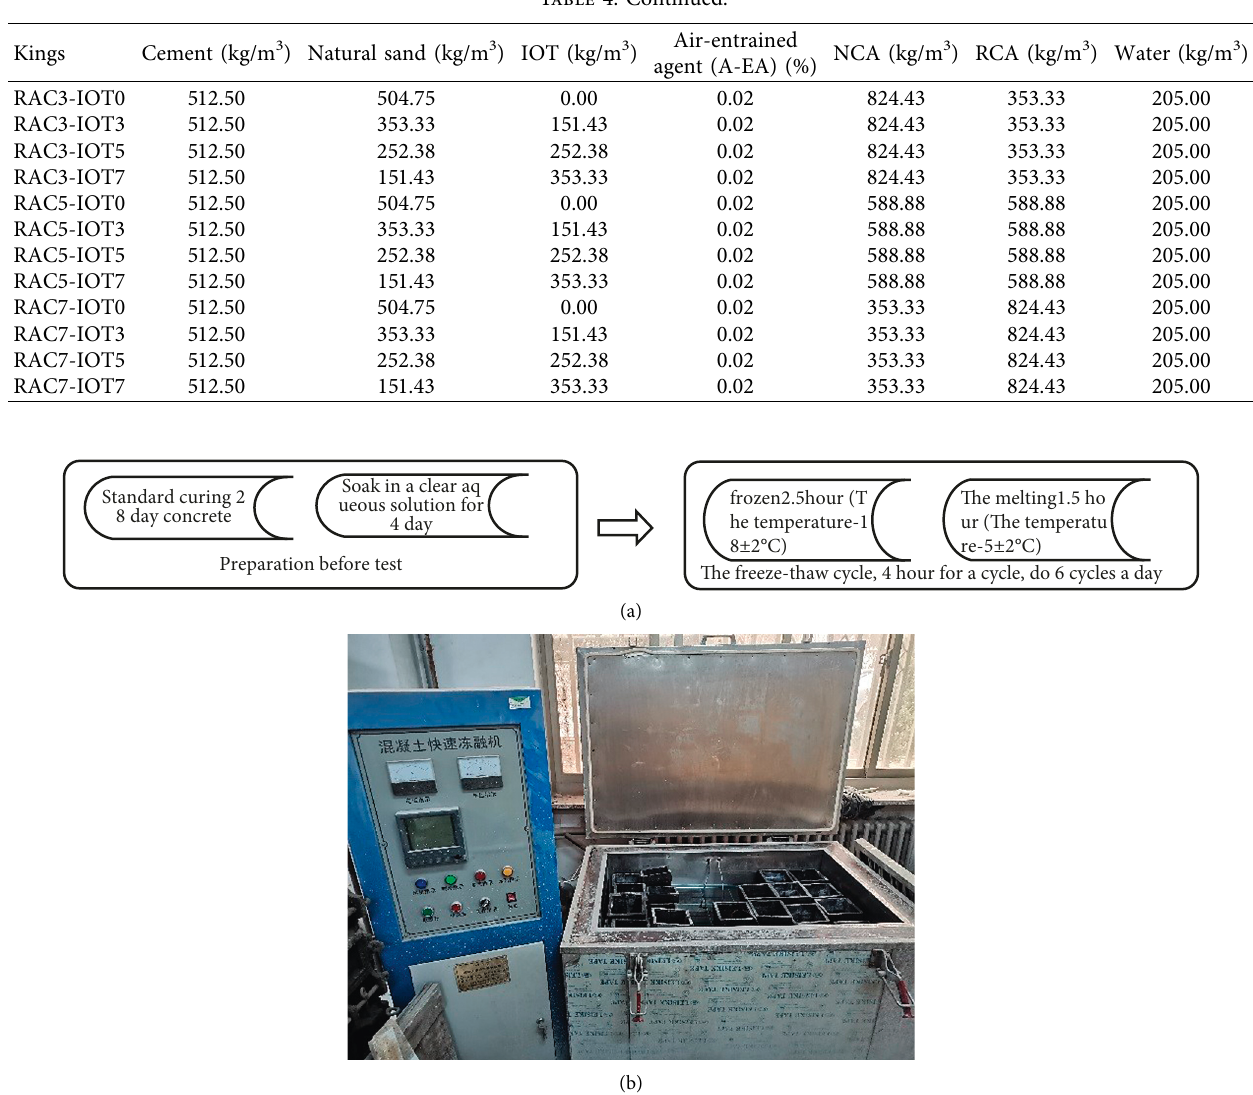
Figure 4: F-T cycle flow chart and F-T cycle machine; (a) F-T cycle flow chart; (b) F-T cycle